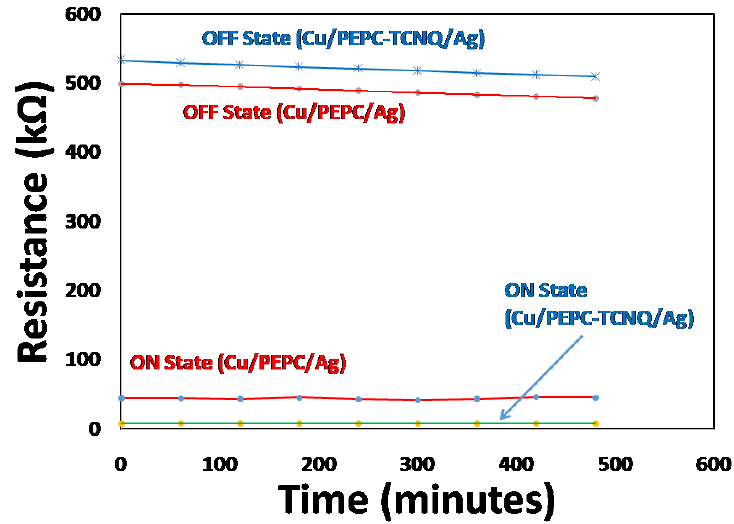
Figure 6. Degradation of ON state and OFF state resistance as a function of time for Cu/PEPC/Ag and Cu/PEPC-TCNQ/Ag devices after heating and holding the sample at 60 °C for ~1 h duration.